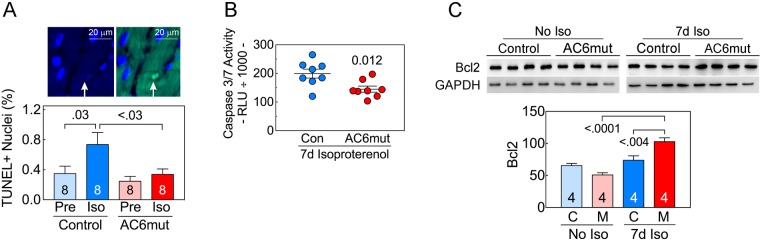
Cardiac myocyte apoptosis.A.
Upper Panel: Example of TUNEL positive nucleus in photomicrographs from confocal microscopic images of transmural LV sections. Nuclei were stained with DAPI (blue) and apoptotic nuclei with broken DNA were labeled with FITC (green). Lower Panel: Quantitative analysis of cardiac myocyte apoptosis in AC6mut vs control mice before (Pre) and after continuous isoproterenol infusion showed group differences (2-Way ANOVA: Interaction: p = 0.17; Iso: p = 0.03; Gene: p<0.03). Cardiac myocyte apoptosis was increased >2.1-fold in control mice after isoproterenol infusion (p = 0.03), but was not increased in LV samples from mice with cardiac-directed AC6mut expression. Control mice showed more apoptosis vs AC6mut mice after 7d isoproterenol (p<0.03). Between-group comparisons made using Sidak’s multiple comparison test. B. After 7d isoproterenol infusion, LV caspase 3/7 activity was greater in control mice (Con) than in AC6mut mice (p = 0.012, Student’s t-test, unpaired, 2-tailed). C. LV Bcl2 protein content showed group differences (2-Way ANOVA: Interaction: p = 0.001; Iso: p<0.0001; Gene: p = 0.19). Seven days after continuous isoproterenol infusion, LV Bcl2 was increased in AC6mut mice (M), compared to control mice (p<0.0001). Bcl2 was increased after 7d isoproterenol infusion in AC6mut (p<0.004). Between-group comparisons made using Sidak’s multiple comparison tests. In all graphs mean ±SE are shown. In C, summary data are normalized to GAPDH.